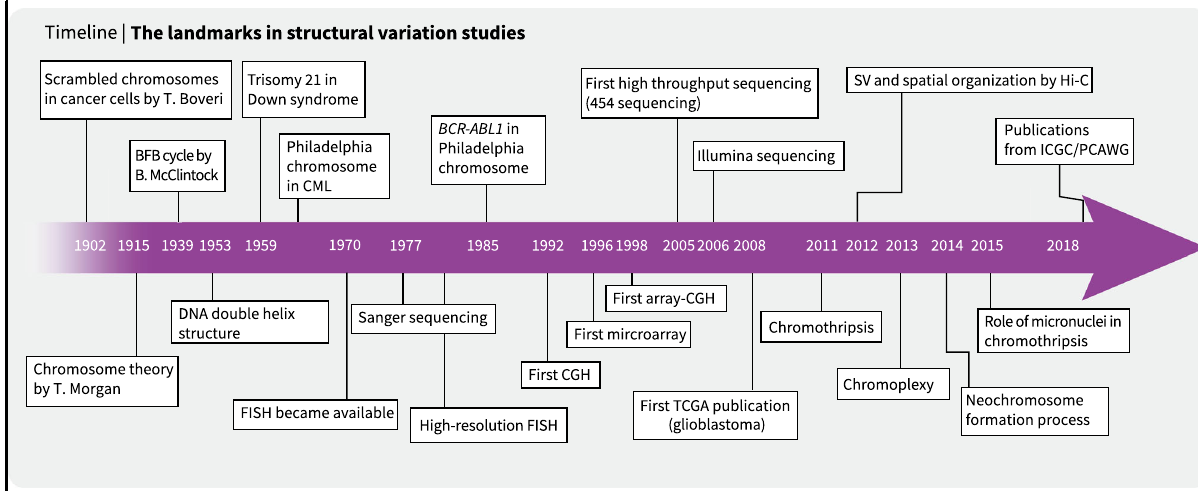
Fig. 1 The history of structural variation